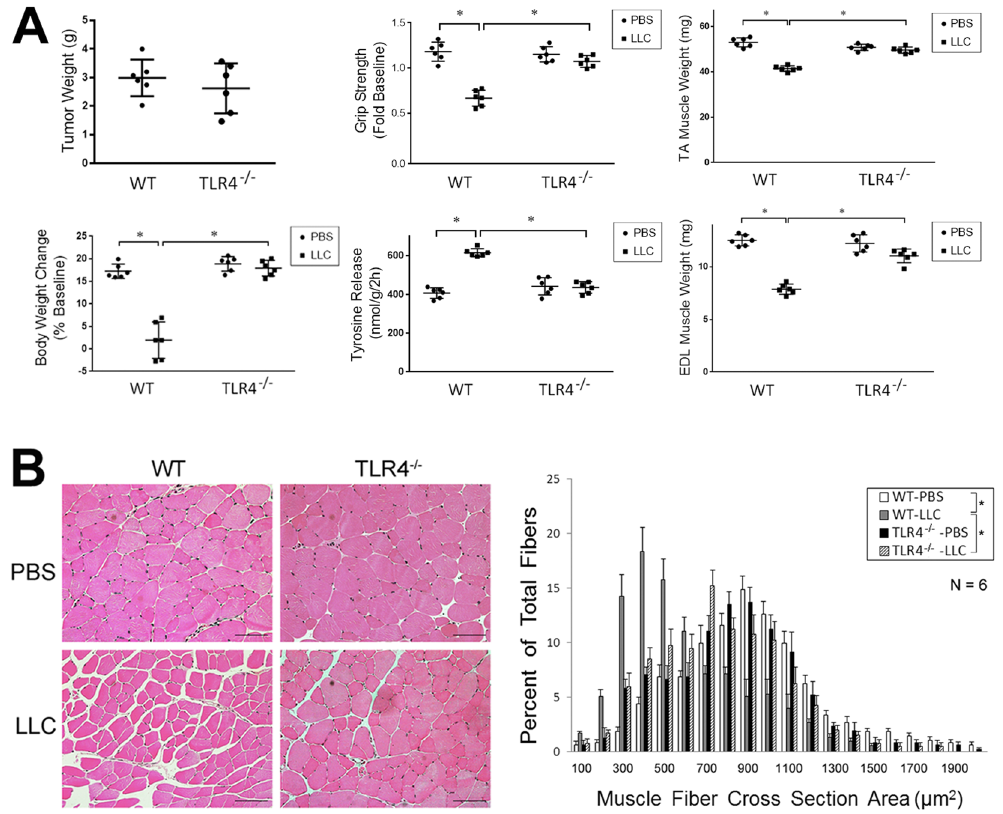
Figure 3. TLR4 − / − mice are resistant to LLC tumor-induced muscle wasting. Wild-type C57BL/6 and TLR4 − / − mice (7-week old male) were inoculated with LLC cells. Muscle wasting was evaluated in 21 days by measuring tumor mass, body weight change (excluding tumor weight), grip strength, tyrosine release from EDL, muscle weight (TA and EDL) ( A ) as well as muscle fiber cross-sectional area ( B ). Bar = 100 μ m. Data was analyzed by ANOVA ( A ) or Chi-square analysis ( B ). * Denotes a difference ( P <